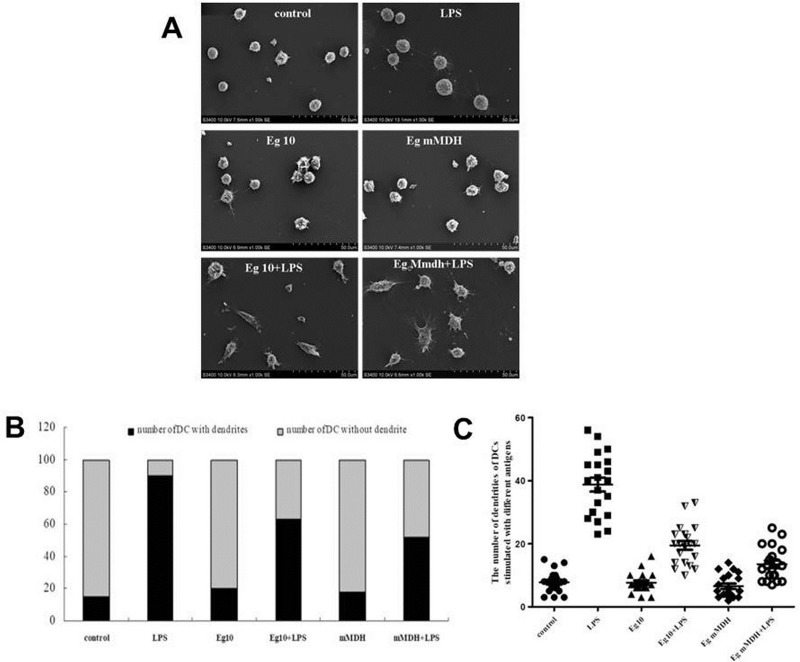
Echinococcus granulosus antigens effect on DC morphologic change.(A). DCs exposed to the various antigens were observed with a scanning electron microscope (SEM). (B). Quantification of the number of stimulated DCs that contain dendrites. Comparison of the ratio of DCs with or without dendrites among the treatment groups (100 DCs were counted randomly in each group). (C). DCs were cultured as above, and the number of dendrites of each DC was counted under SEM. The average dendrite number was compared between different groups. Bars represent means ± SEM (n = 20). Control means DCs are in RPMI1640 culture medium.